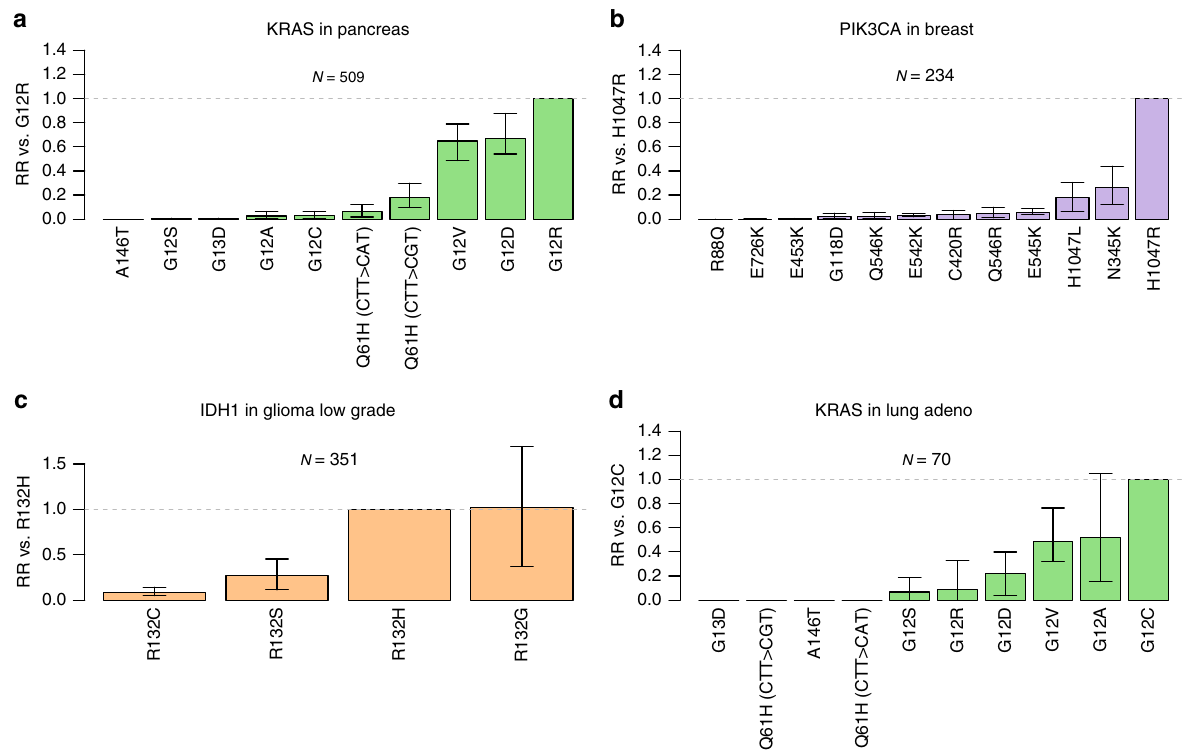
Fig. 3 Evidence for differential selection between mutations in the same driver gene. a Modelled relative risk (RR) of frequent KRAS mutations in pancreatic cancer compared with KRAS G12R . For each mutation, the maximum likelihood estimate of relative risk compared to KRAS G12R is shown. b , c and d illustrate modelled relative risk for respectively, PIK3CA mutations in breast cancer, IDH1 mutations in glioma low grade and KRAS mutations in lung adenocarcinoma. Grey dashed line indicates relative risk of one. Error bars represent 95% con fi dence intervals obtained by bootstrapping across 100 iterations. N indicates the number of samples used for the analysis within each cancer